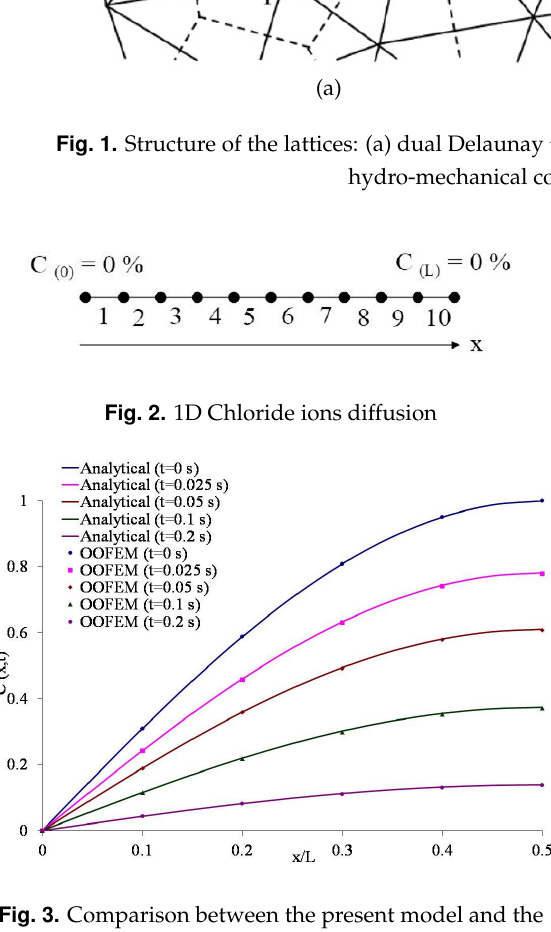
Fig. 3. Comparison between the present model and the closed-form solution (5)